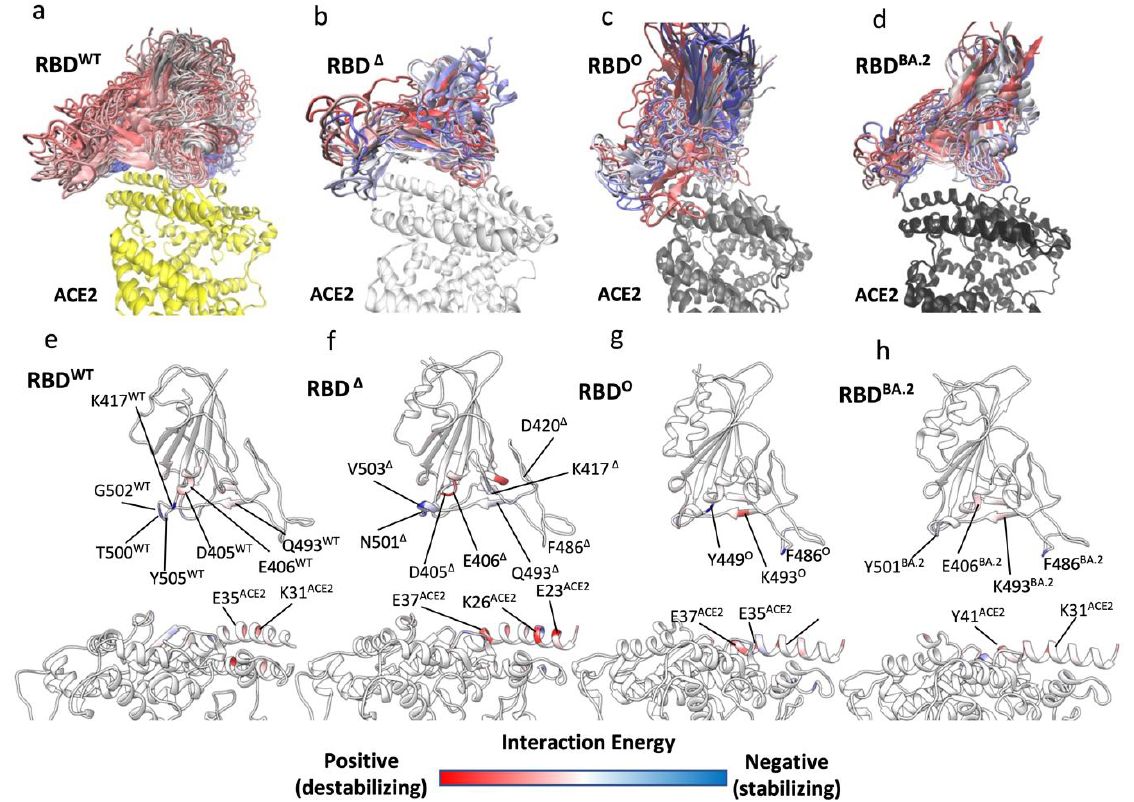
Figure 3. SuMD binding of RBD ∆ , RBD ◦ , and RBD BA.2 to ACE2: ( a – d ) Snapshots of ACE2:RBD WT , ACE2:RBD ∆ , RBD ◦ , and RBD BA.2 unstable complexes (MM-GBSA energy > 5 kcal mol − 1 ) from SuMD replicas. RBD WT , RBD ∆ , RBD ◦ , and RBD BA.2 are coloured from blue to red to distinguish different frames; ACE2 in complex with RBD WT is represented by a yellow ribbon. ( e – h ) Per residue energy decomposition of RBD WT , RBD ∆ , RBD ◦ , and RBD BA.2 in the unstable states from SuMD binding simulations to ACE2; only frames with binding energy > 5 kcal mol − 1 were analysed. ∆ In three SuMD replicas out of the best four, the ACE2:RBD complex reached RMSD values to the final bound complex of 5 Å or less (Figure S3a), in line with equilibrium